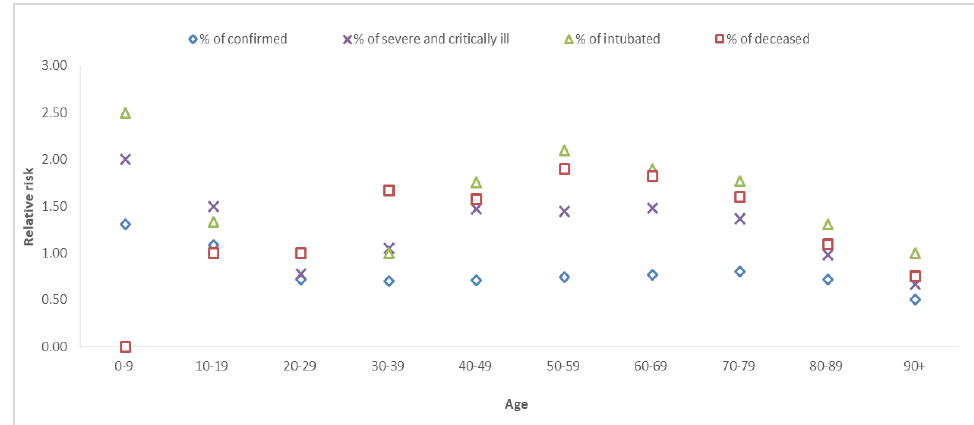
Figure 1. Relative risk between males and females (male/female), by age.